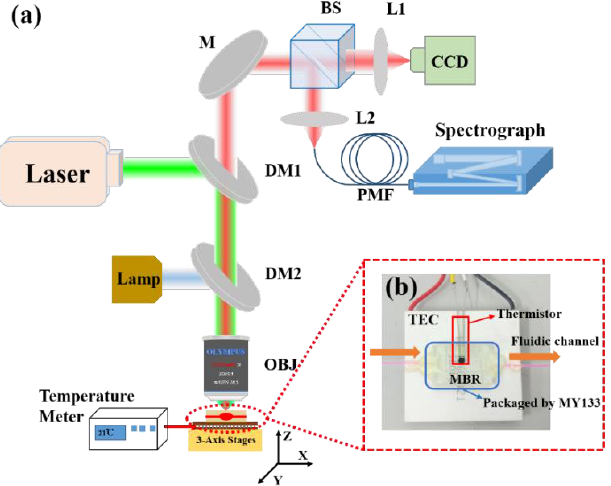
Figure 5. ( a ) The experimental setup schematic diagram of the WGM thermal sensor. OBJ: objective; M: mirror; L: lens; BS: beam splitter; DM: dichroic mirror; PMF: polarization maintaining fiber. ( b ) Optical image of the configuration of packaged MBR.